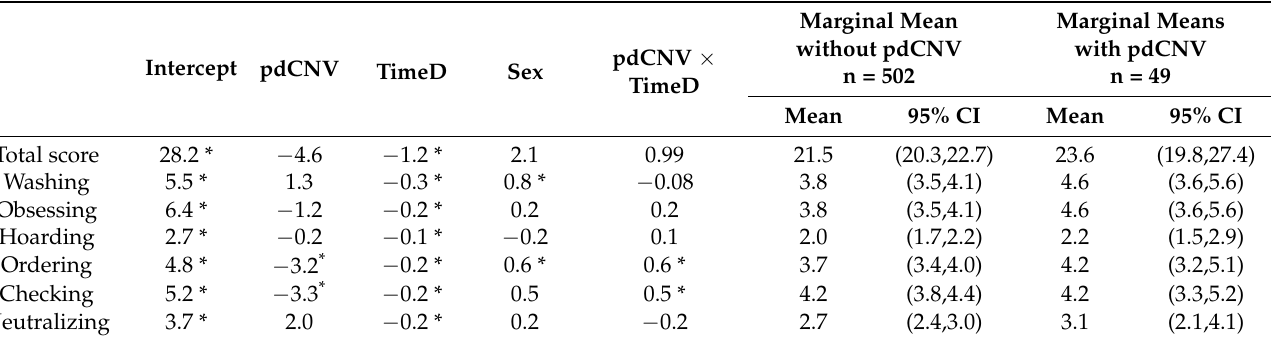
Table 7. Severity of OCD symptoms based on OCI-R score for probands with and without potentially damaging